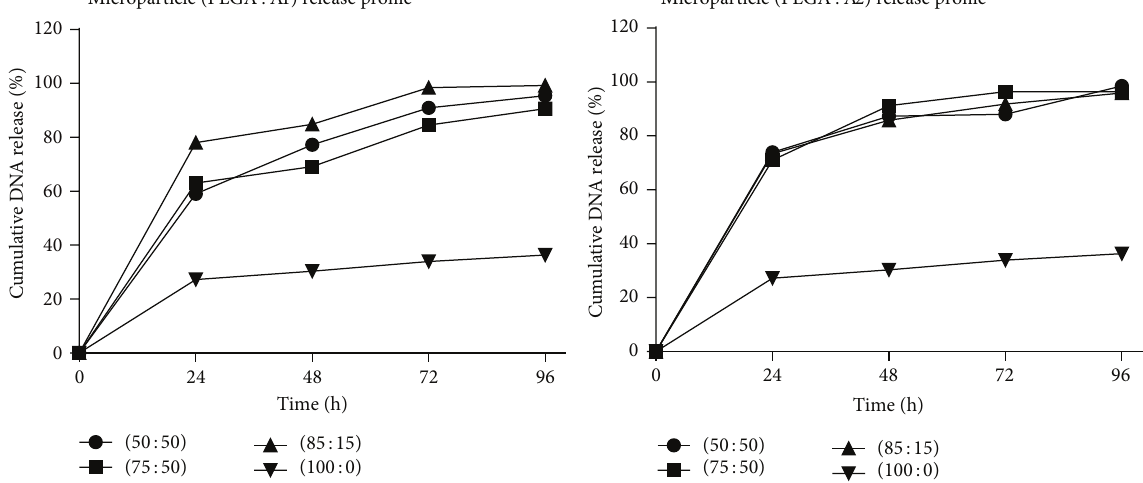
Figure 2: DNA release profile from microparticles.